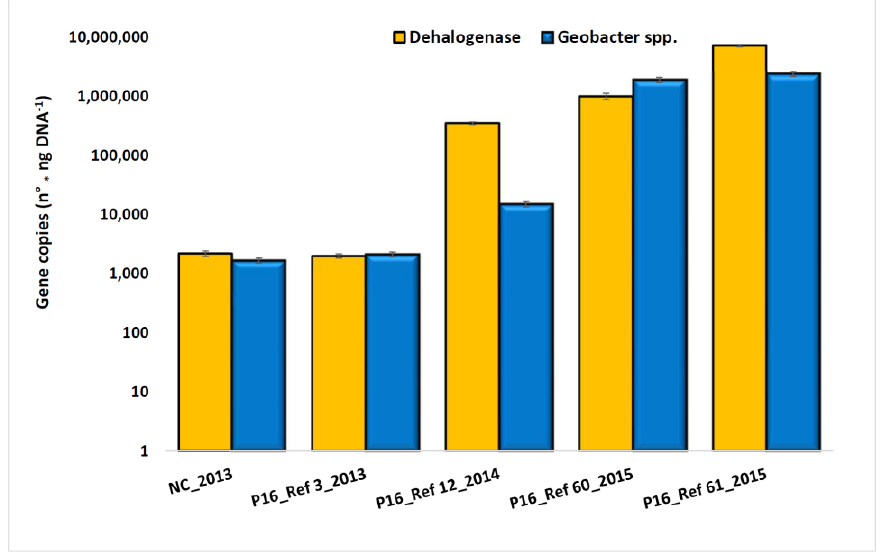
Figure 4. Quantitative PCR (qPCR) experiments results: determination of the reductive dehalogenase gene ( rdh ) and Geo- bacter spp. 16SrRNA copy number in subsequent enrichment cultures. NC is the non-enriched culture (that is, no refresh) microcosm at the beginning.